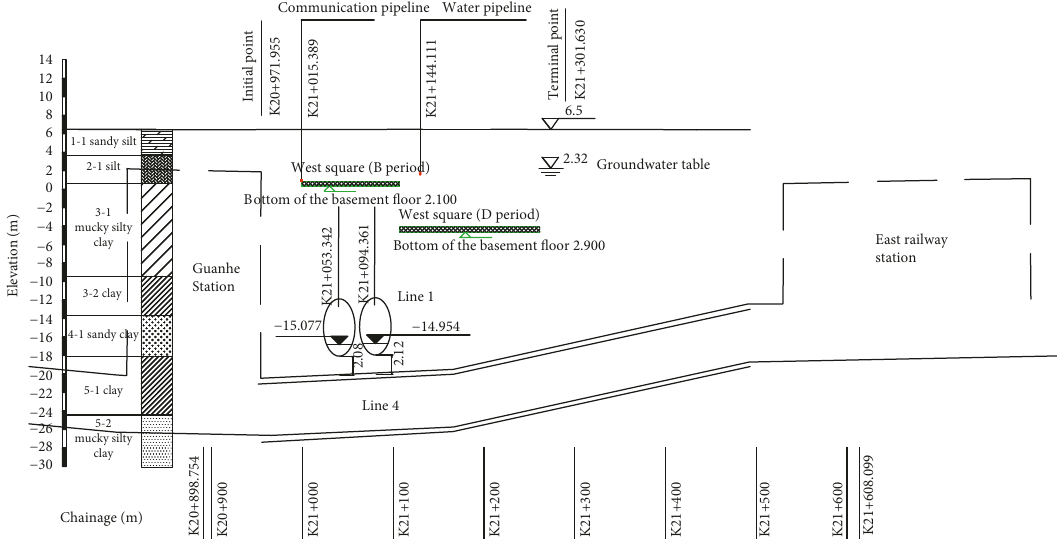
Figure 3: Longitudinal profile of soils and